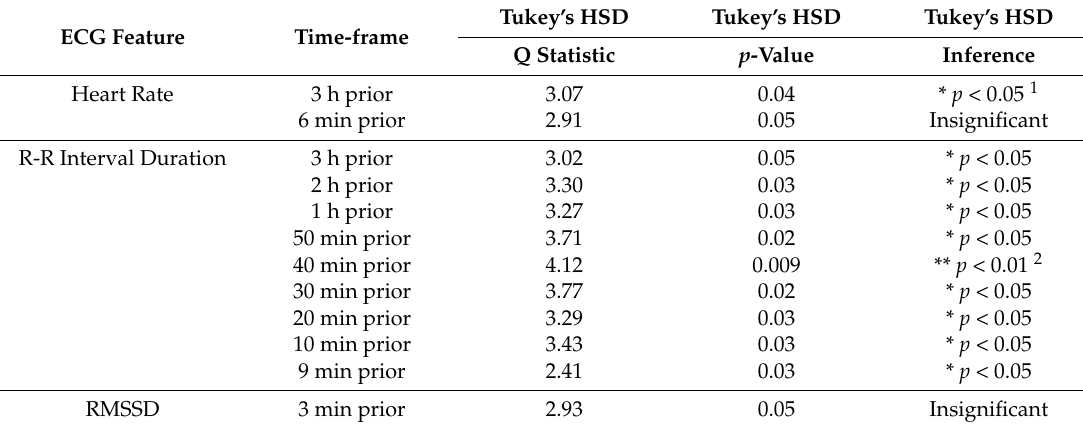
Table A4. Tabular summary of post-hoc Tukey’s HSD conducted on ECG feature extracted from the normal patient cohort vs. the SCA patient cohort at time-frames which have reached statistical significance ( n =